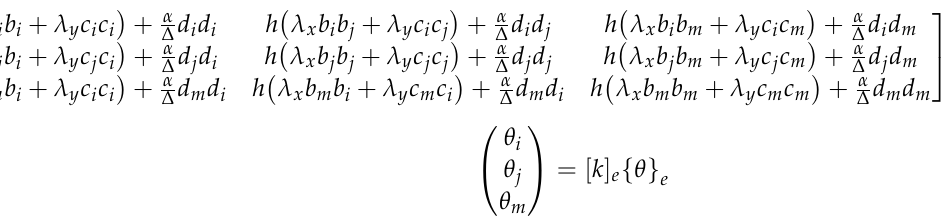
The right member. Term 1 represents the heat flux of the internal heat sources: h (cid:120) MN i